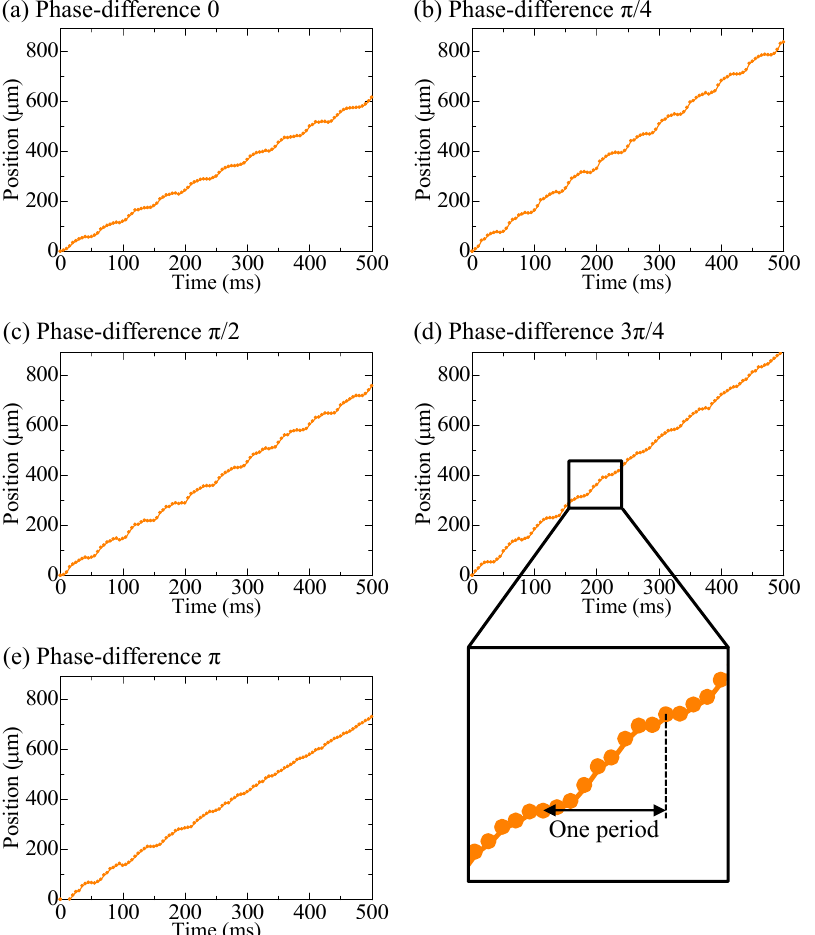
Figure 9. Bead positions when driving a series pump, where ( a – e ) show the phase differences of 0, π /4, π /2, 3 π /4, and π , respectively, and the enlarged graph shows one period at the phase-difference of 3 π /4, which was the condition for minimum